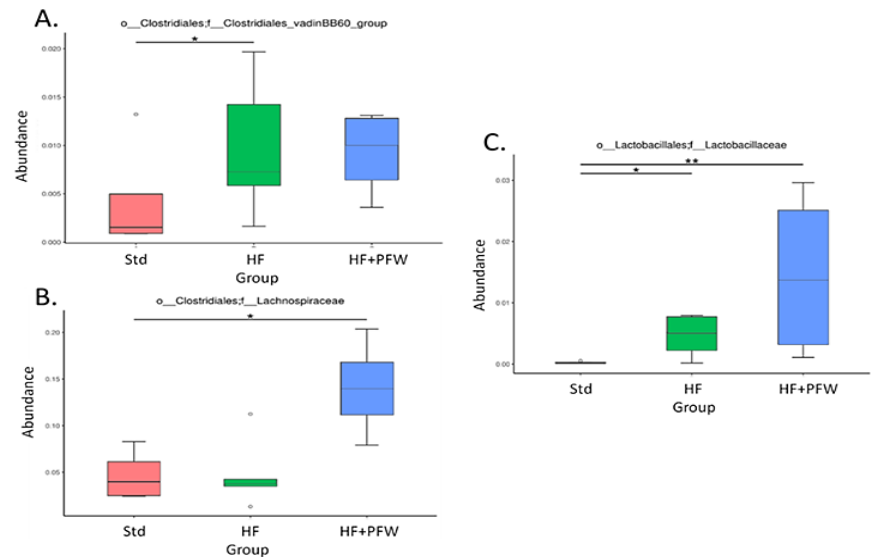
Figure 8. Relative abundance of the gut microbiota in mice under PFW treatment. The abundance of Clostridiales ( A ), Lachnospiraceae ( B ), and Lactobacillaceae ( C ) changed significantly among the groups. * p < 0.05, ** p < 0.01 compared with the Std group. Group Std, standard diet; group HF, high-fat diet; group HF+PFW, high-fat diet plus PFW